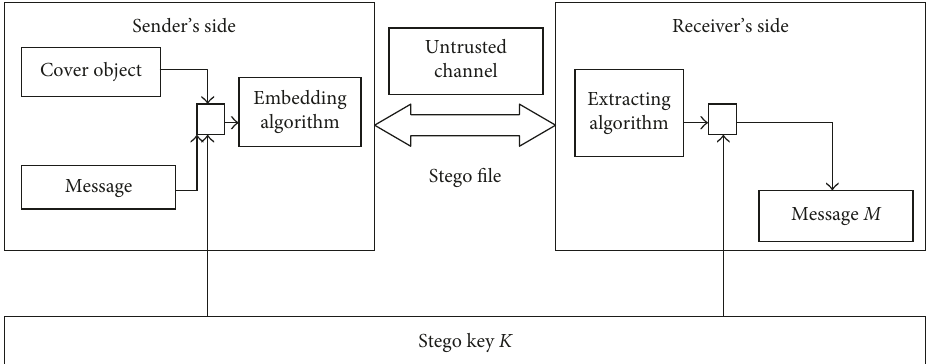
Figure 1: Steganography